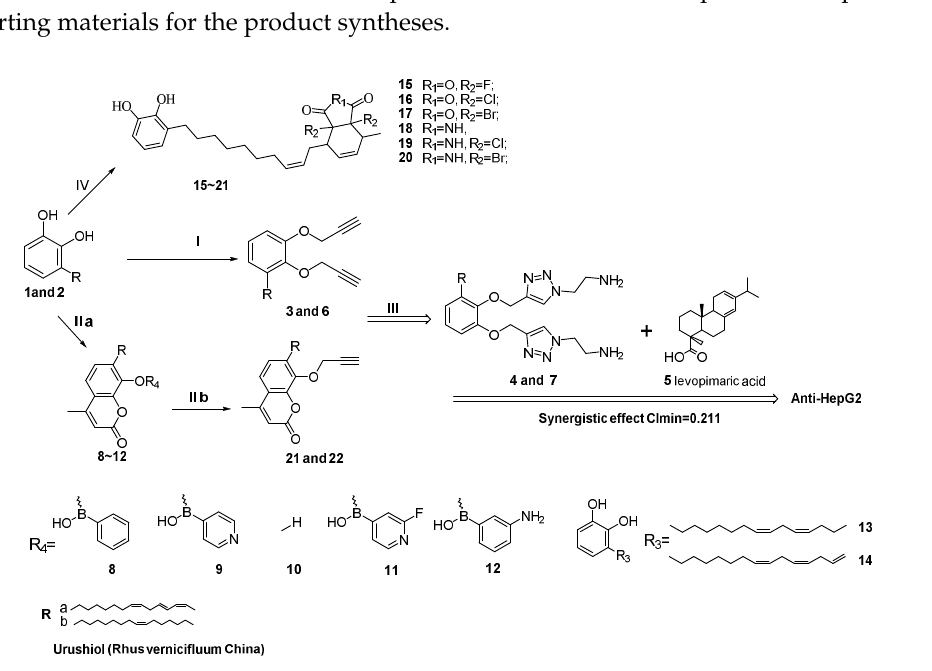
Figure 9. Confidence interval CI–Fa relationship ( a ) (CI = 0.211) and HepG2 apoptosis ( b ). Statistical analysis: A p < 0.05 was considered